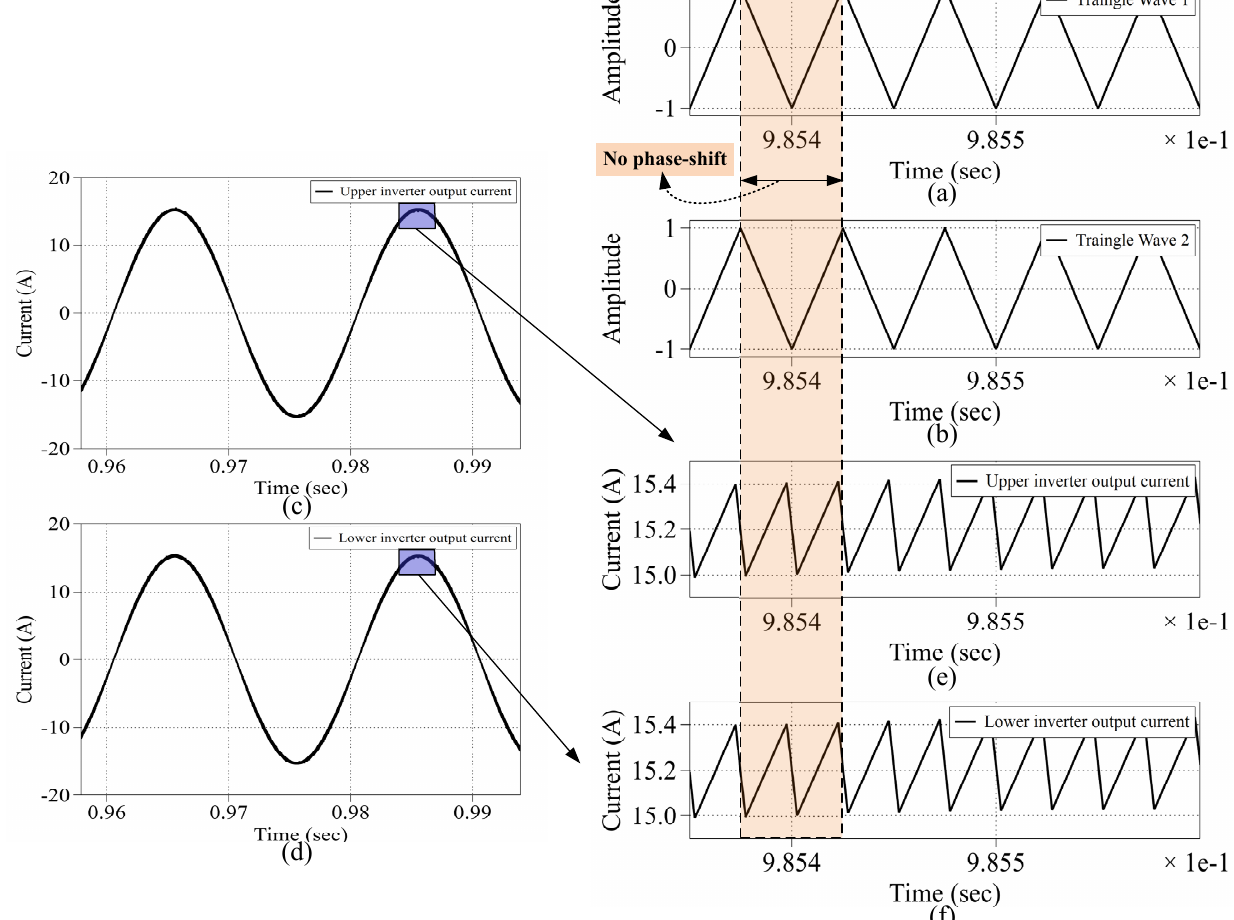
Figure 5. Parallel-connected system waves using the conventional method: ( a ) upper inverter carrier wave, ( b ) lower inverter carrier wave, ( c ) upper inverter output current wave, ( d ) lower inverter output current wave, ( e ) output current ripples of upper inverter, and ( f ) output current ripples of the lower